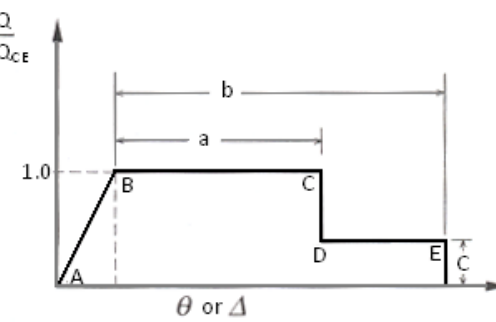
Fig. 3. An example of force -deformation curve of nonlinear hinges according to FEMA 273